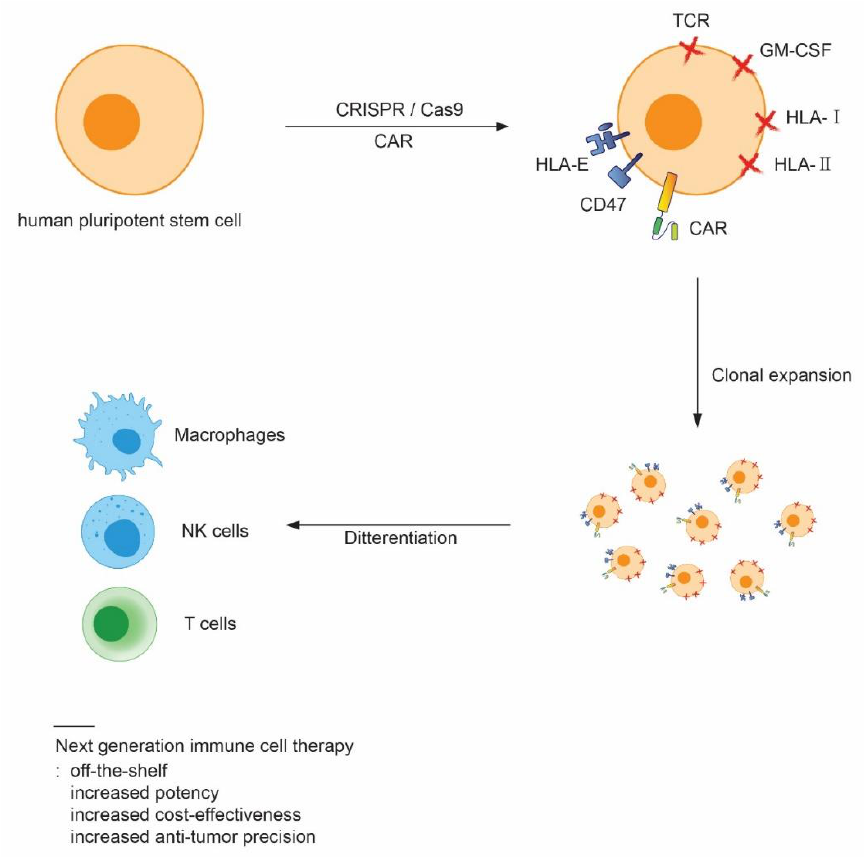
Figure 3. Overview of future strategies for developing next generation immune cell therapy from human pluripotent stem cells. By deploying CAR and clustered regularly interspaced short palindromic repeats (CRISPR/Cas9 technologies, human pluripotent stem cells can be engineered to knockout the genes related to immune rejection, cytokine release syndrome, or to express fourth generation CAR, which can be utilized for precise anti-tumor activity and safety. The engineered human pluripotent stem cells can be clonally selected and expanded. The clonally expanded cells differentiated to immune cells for the therapy. This approach can generate next generation immune cells, which can pave a new way for developing immune cell therapy with off-the shelf, increased potency, increased cost-effectiveness, and an increase in anti-tumor activity precision.